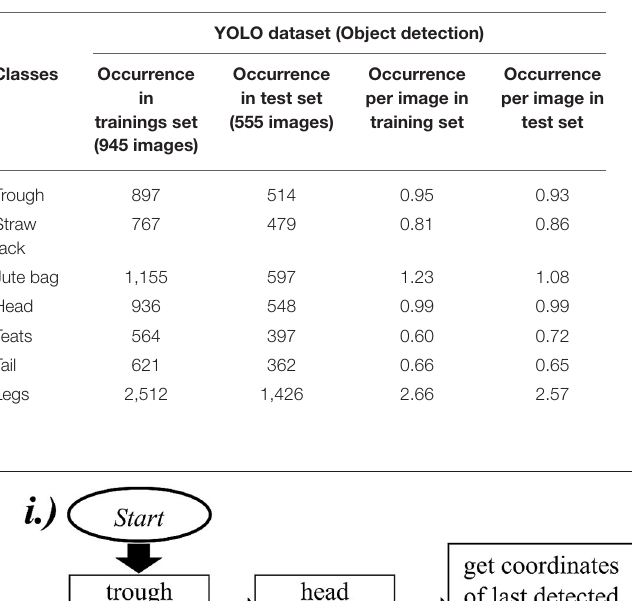
TABLE 1 | Structure of the YOLO-datasets.